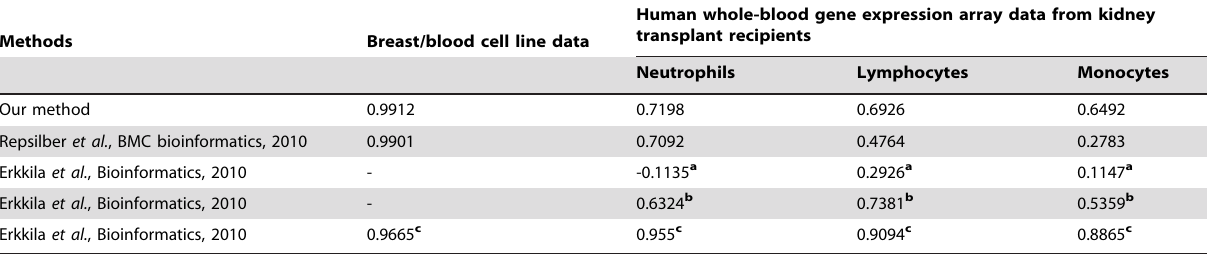
Table 3. The comparison of deconvolution methods on cell line data and Shen-Orr et al. ’s 24 whole-blood microarray data.